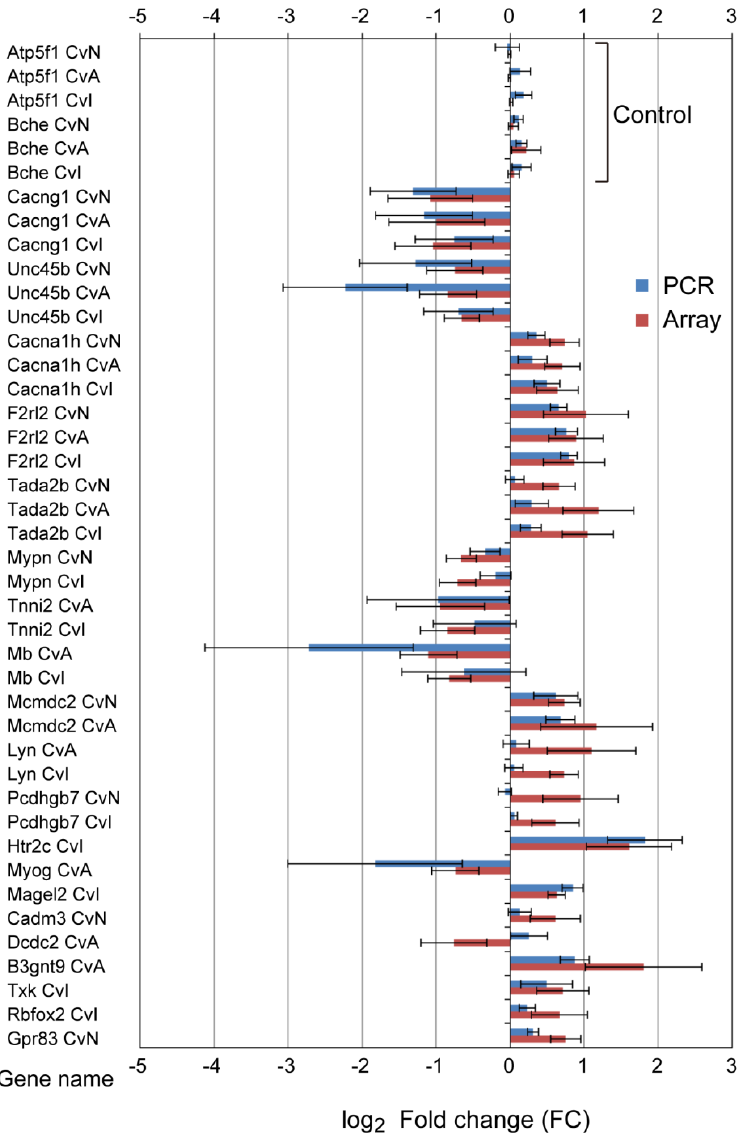
Figure 5. Confirmation of the microarray data using quantitative real-time PCR (qRT-PCR). Twenty DE genes and two control genes were selected at random for validation. Red bars, microarray data; blue bars, qRT-PCR data. The qRT-PCR data were normalized against the reference gene Actb; similar results were obtained using Gapdh as reference (not shown). The similarity of the expression patterns (up- and downregulation) between the microarray and qRT-PCR analyses confirmed the results of the microarray. Error bars represent standard errors from six experiments. Control genes’ descriptions are follows; Atp5f1, ATP synthase, H + transporting, mitochondrial Fo complex, subunit B1; Bche, butyrylcholinesterase.